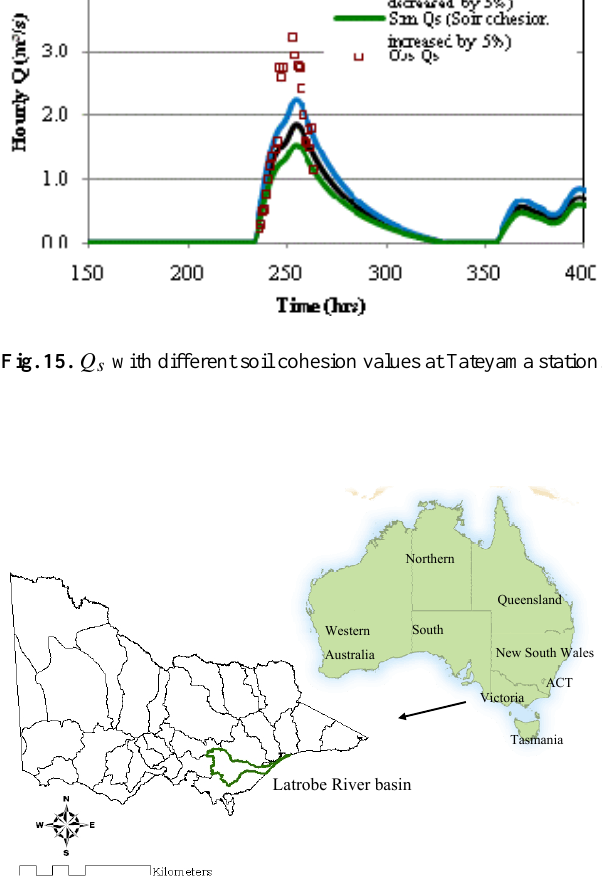
Fig. 18. Water discharges at Rosedale with basin avg. rainfall (ML=Mega liters).